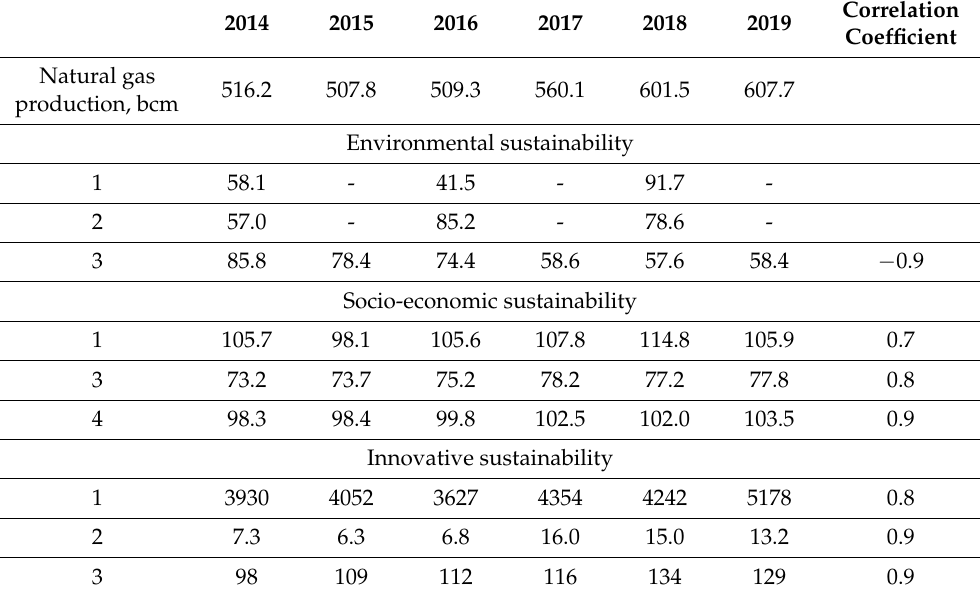
Table 3. Indicators of the development of the Yamalo-Nenets Autonomous Okrug within the frame- work of the proposed sustainability